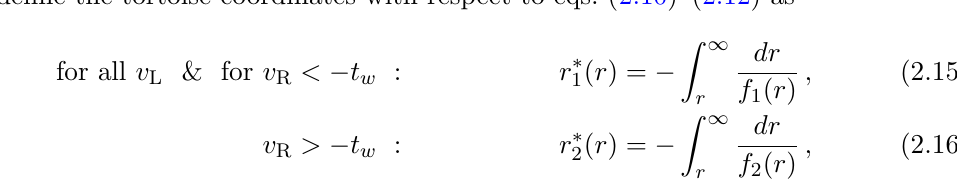
Figure 1. Penrose-like diagram for one shock wave on an eternal black hole geometry. At v a thin shock is injected at the right boundary which raises the mass of the black hole from M 1 to M 2 . We identify three points in the geometry that depend on time, r m , where the boundaries of the WDW patch cross behind the past horizon, r s , where the boundary of the WDW patch crosses the collapsing shell in the right exterior, and r b where the boundary of the WDW patch crosses the shock wave inside the future black